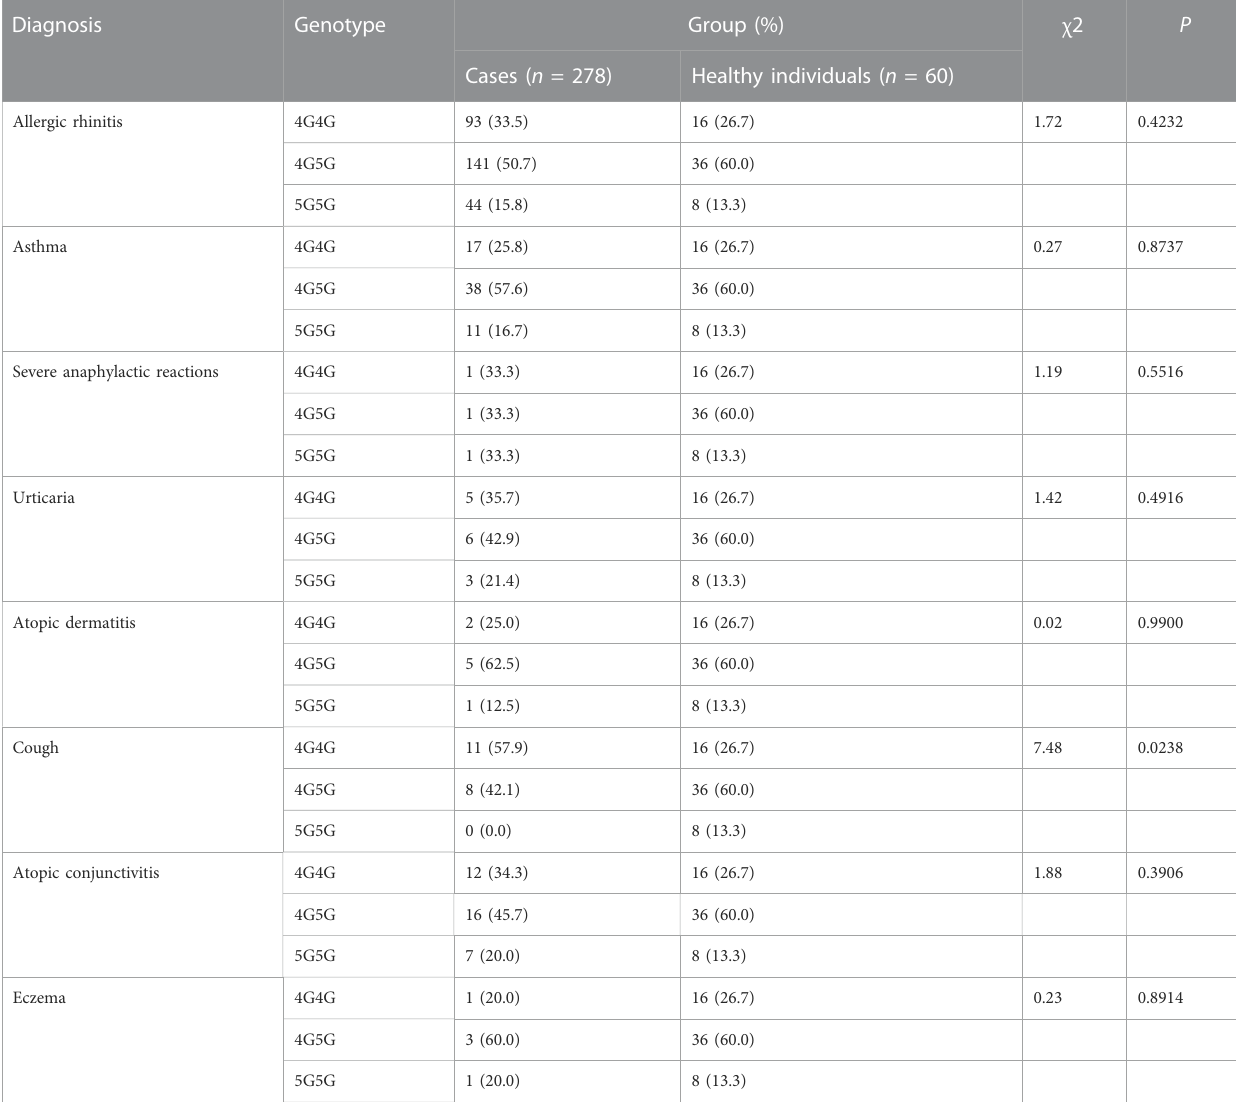
TABLE 2 Analysis of Association of PAI-1 rs1799762 ( − 675,4G5G) with Genetic Susceptibility to